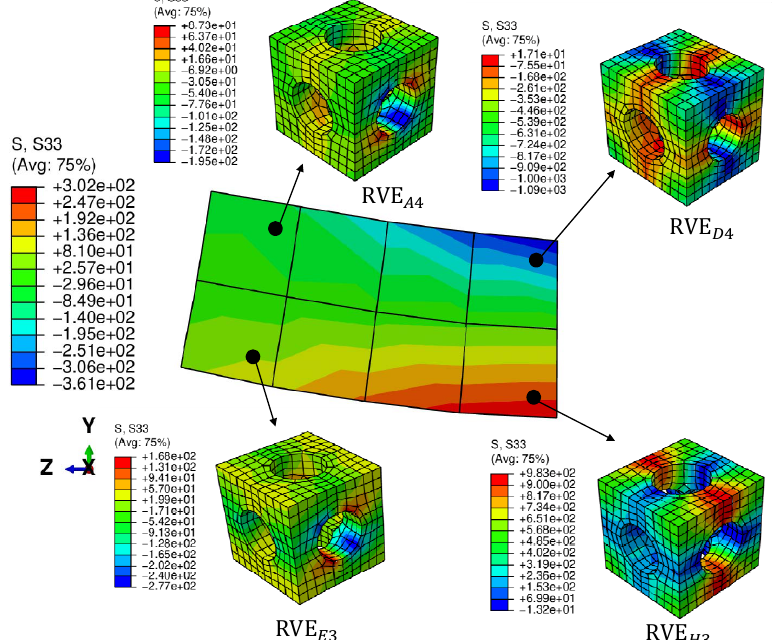
Figure 16. The distribution of stress in Z direction (S33) for the macroscopic structure and microscopic structure with ξ = 40.7%, where the deformations of both levels are magnified by three